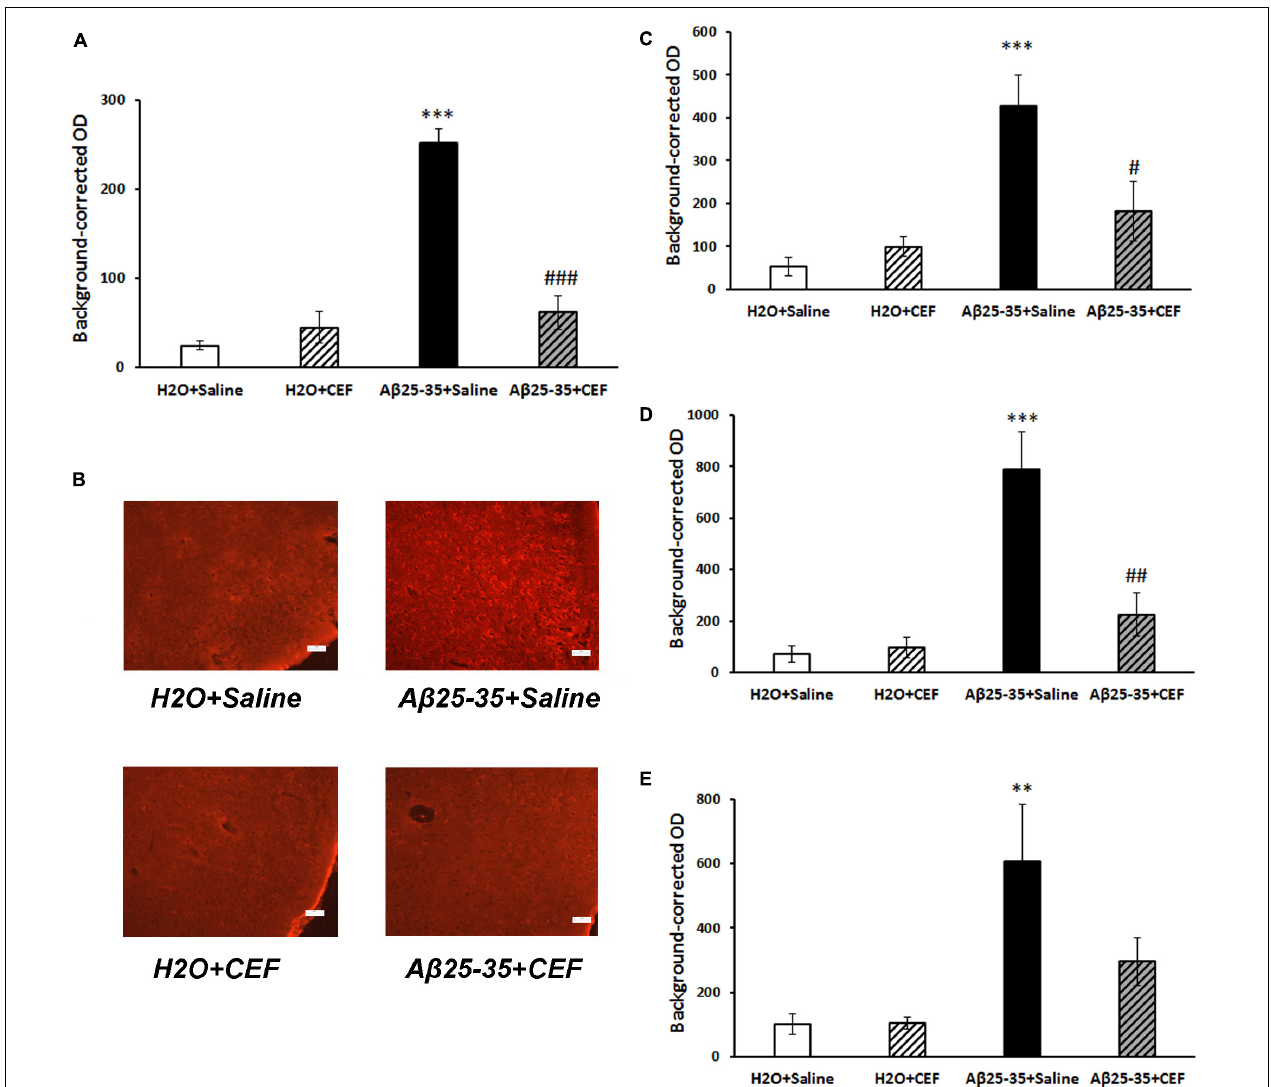
FIGURE 4 | Effects of the CEF and A β 25–35 administration (AD model) on the A β accumulation in the frontal cortex (A,B) or hippocampus ( C in the CA1 area; D in the CA3 area; E in the dentate gyrus) in mice. (A,C–E) Quantitative results. The data are expressed as mean ± SEM of the values obtained in an independent group of animals ( n = 3–4 per group). Statistically significant differences: ∗∗ p < 0.01, ∗∗∗ p < 0.001 vs. the “H 2 O + saline” group; # p < 0.05, ## p < 0.01, ### p < 0.001 vs. the “A β + saline” group. (B) A β immunoreactivity in the frontal cortex. Magnification, × 200; bar, 50 µ